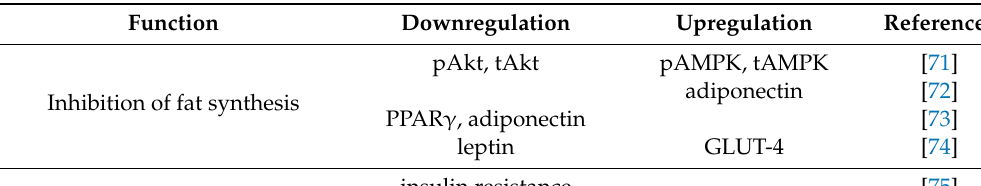
Promotion of glucose utilization